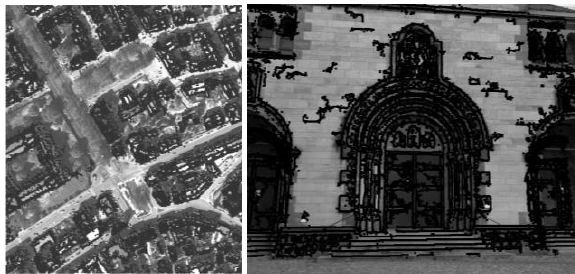
Figure 6. Geometric edge regions projected into the images. - Edge extraction on image . The Canny’s operator thresholds are stressed in order to preserve the edge continuity. In